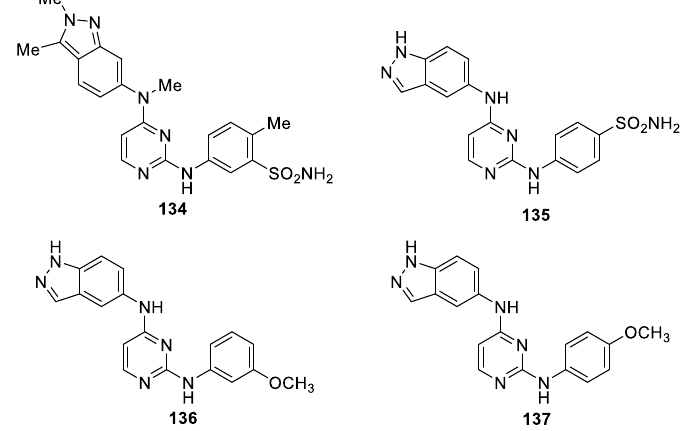
Figure 35. Chemical structures of indazole–pyrimidine derivatives 134 – 137.